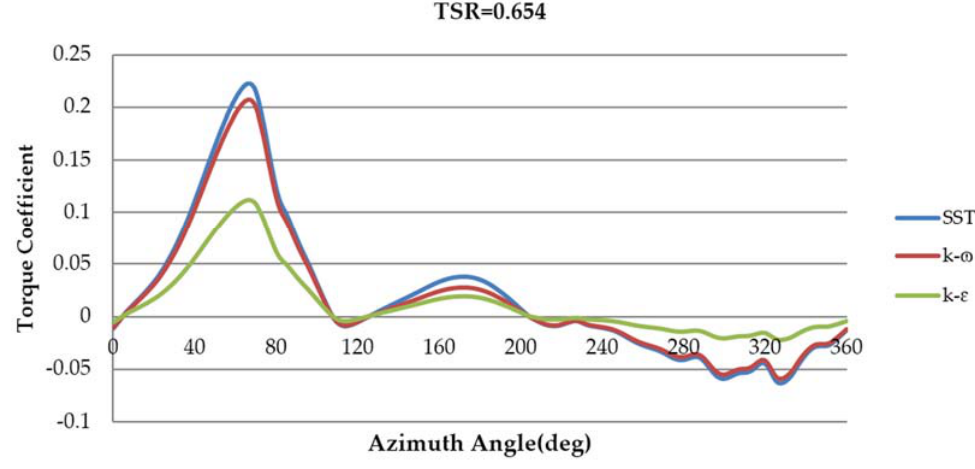
Figure 13. Turbulence models for VAWT simulation.